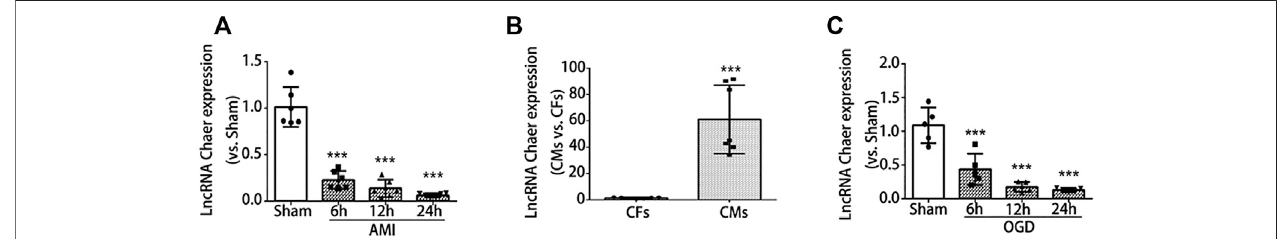
FIGURE 1 | LncRNA Chaer expression was downregulated both in the infarct border zone after AMI and in the cardiomyocytes under OGD treatments. (A) mice were subjected to AMI, and sacri fi ced after 6, 12 and 24 h, then qRT-PCR was conducted to test the relative levels of lncRNA Chaer in the border zone of mouse heart.